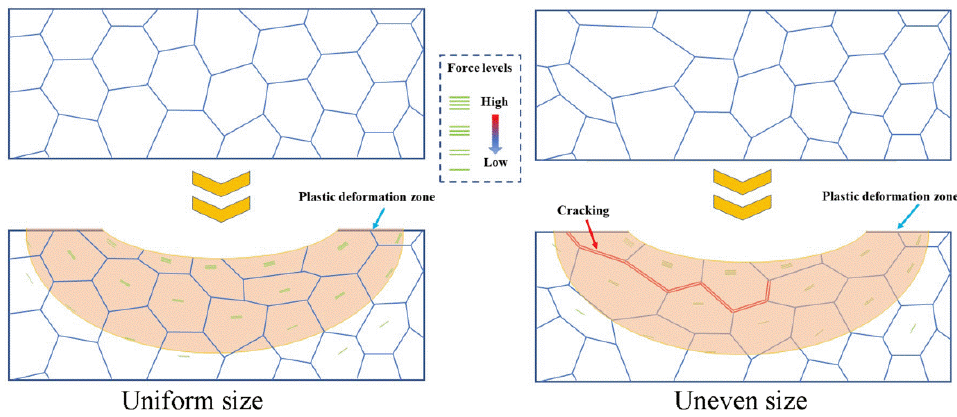
Figure 11. Two different microstructure wear